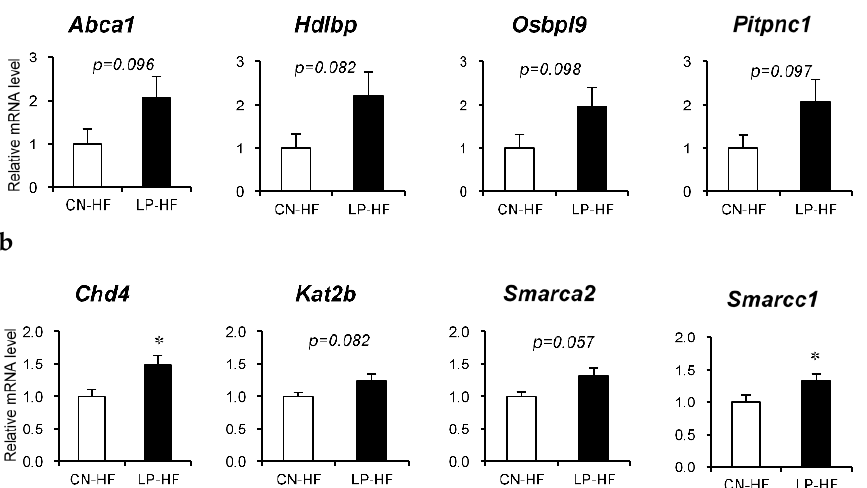
Figure 3. Relative mRNA expression in the liver. Genes that were found to be fluctuating in the DNA microarray were confirmed using real-time reverse-transcription polymerase chain reaction. ( a ) Genes related to lipid localization or lipid transport; ( b ) genes related to chromatin modification or chromatin organization. All values are mean ± standard error (SE; n = 8/9). * p < 0.05 versus CN-HF using Student’s t -test. CN-HF, maternal 20% casein offspring with high-fat diet group; LP-HF, maternal 9% casein offspring with HFD group.